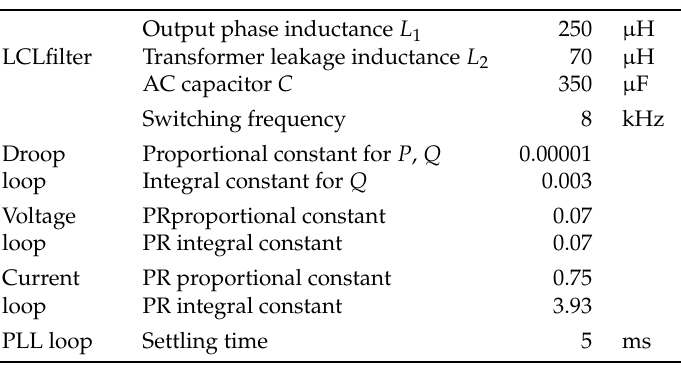
Table 2. Hardware and control parameters.